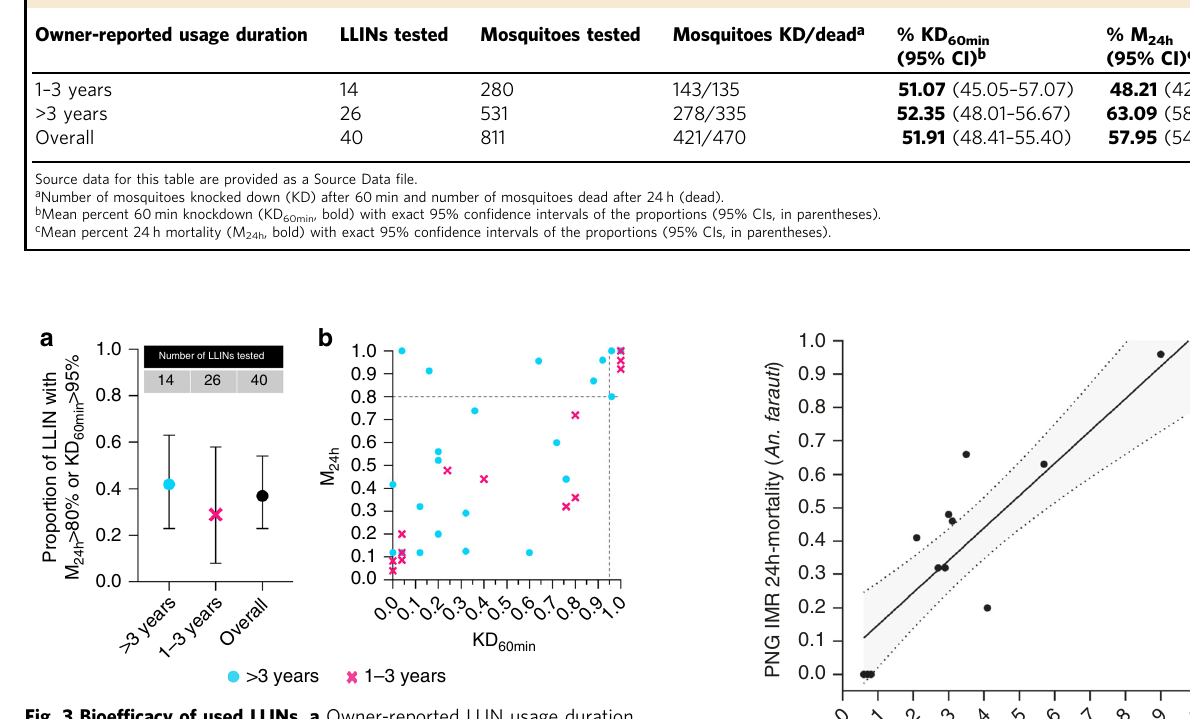
Fig. 3 Bioef fi cacy of used LLINs. a Owner-reported LLIN usage duration versus the proportion of LLINs with either ≥ 95% 60 min knockdown (KD 60min ) or ≥ 80% 24 h mosquito mortality (M 24h ). Data are presented as mean proportions and their exact 95% con fi dence intervals. Data from LLINs with years of manufacture between 2007 – 2012 are presented as turquois circles and from 2013 to 2019 as magenta crosses. Overall data (2007 – 2019) is presented as black circle. The table on top of the panels indicates the numbers of individual LLINs tested in each year or group. b KD 60min versus adjusted M 24h for all used LLINs tested ( n = 40). The dashed lines indicate 95% KD 60min and 80% M 24h thresholds. Each data point represents one bioassay result conducted on one individual, independent LLIN. If the bioassay was valid (positive and negative control mortality <10%), bioassays on individual LLIN samples were not repeated. Source data for this Figure are provided as a Source Data fi le.